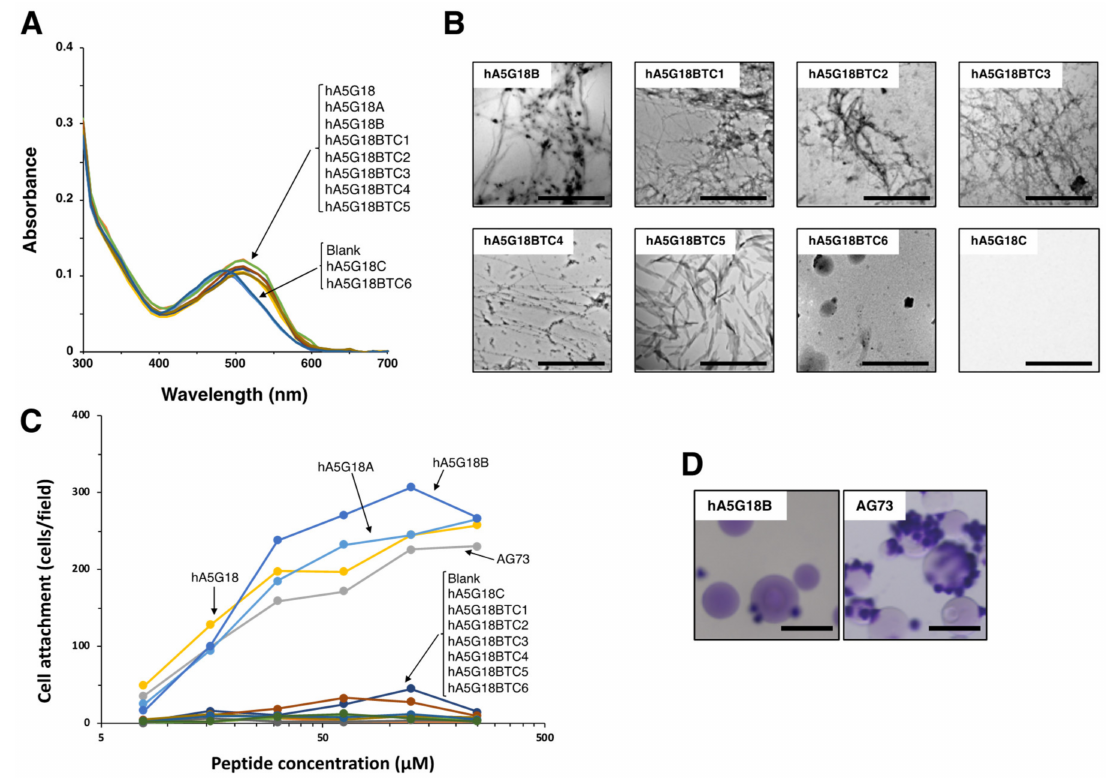
Figure 2. Amyloid-like fibril formation and cell attachment activity of the truncated hA5G18